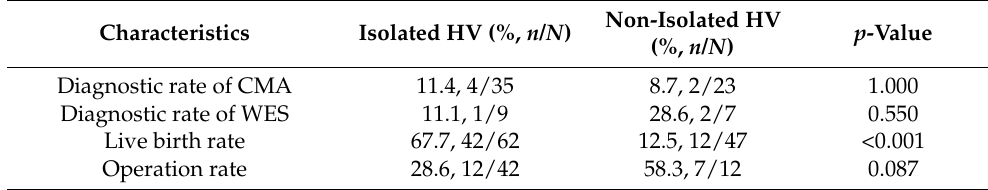
Table 1. Genetic and clinical outcome in fetuses identified sonographically in fetuses with hemivertebra.